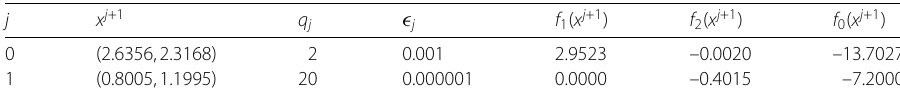
Table 6 Numerical results for Example 4.2 with k = 8